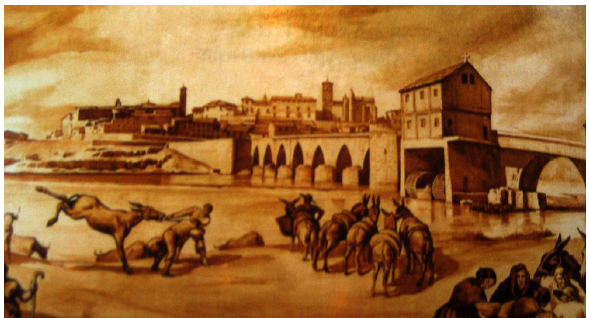
Figure 6: Gravure of Tordesillas including flour fabrics